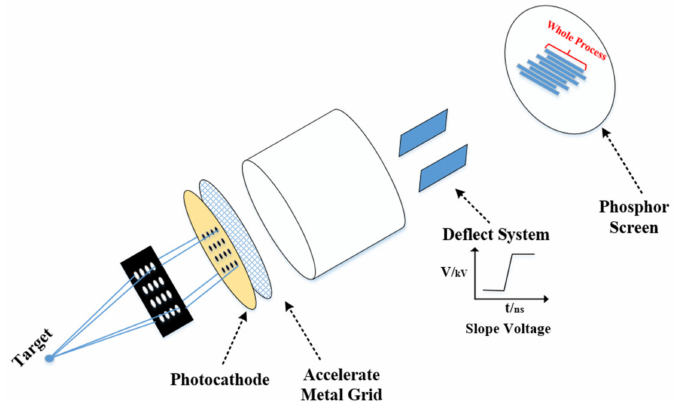
Figure 1. Working principle of 2D sampling streak camera: target is the hot spot in the fusion process; deflect system is composed of a pair of metal